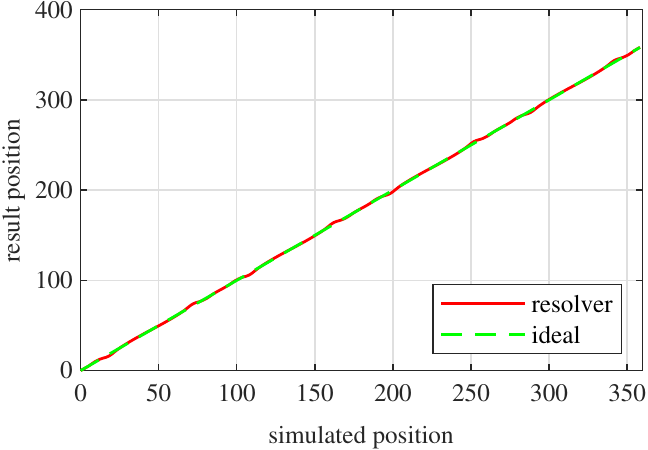
Figure 20. Toroidal four-slot skewed resolver position vs. the ideal position.